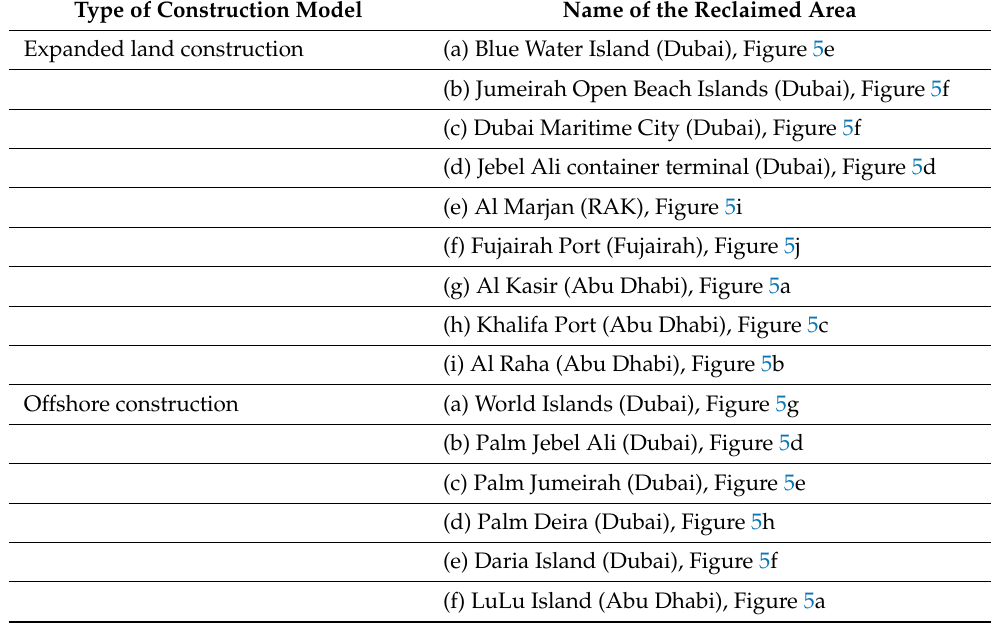
Table 2. Classification of six coastal emirates based on geoengineering construction